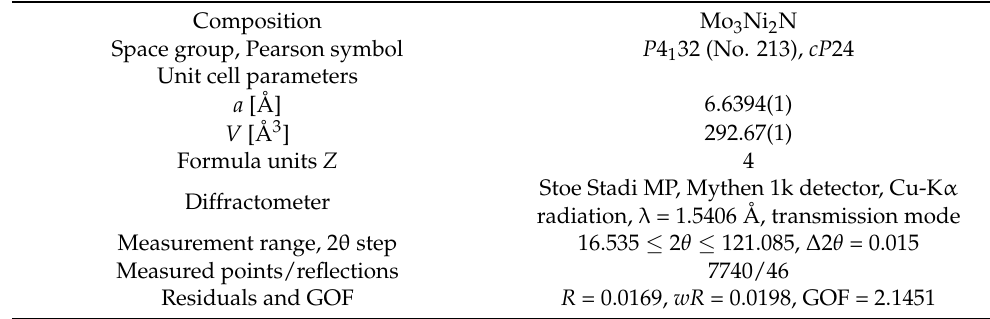
Table 1. X-ray diffraction data for Mo 3 Ni 2 N. Further details on the crystal structure investigations